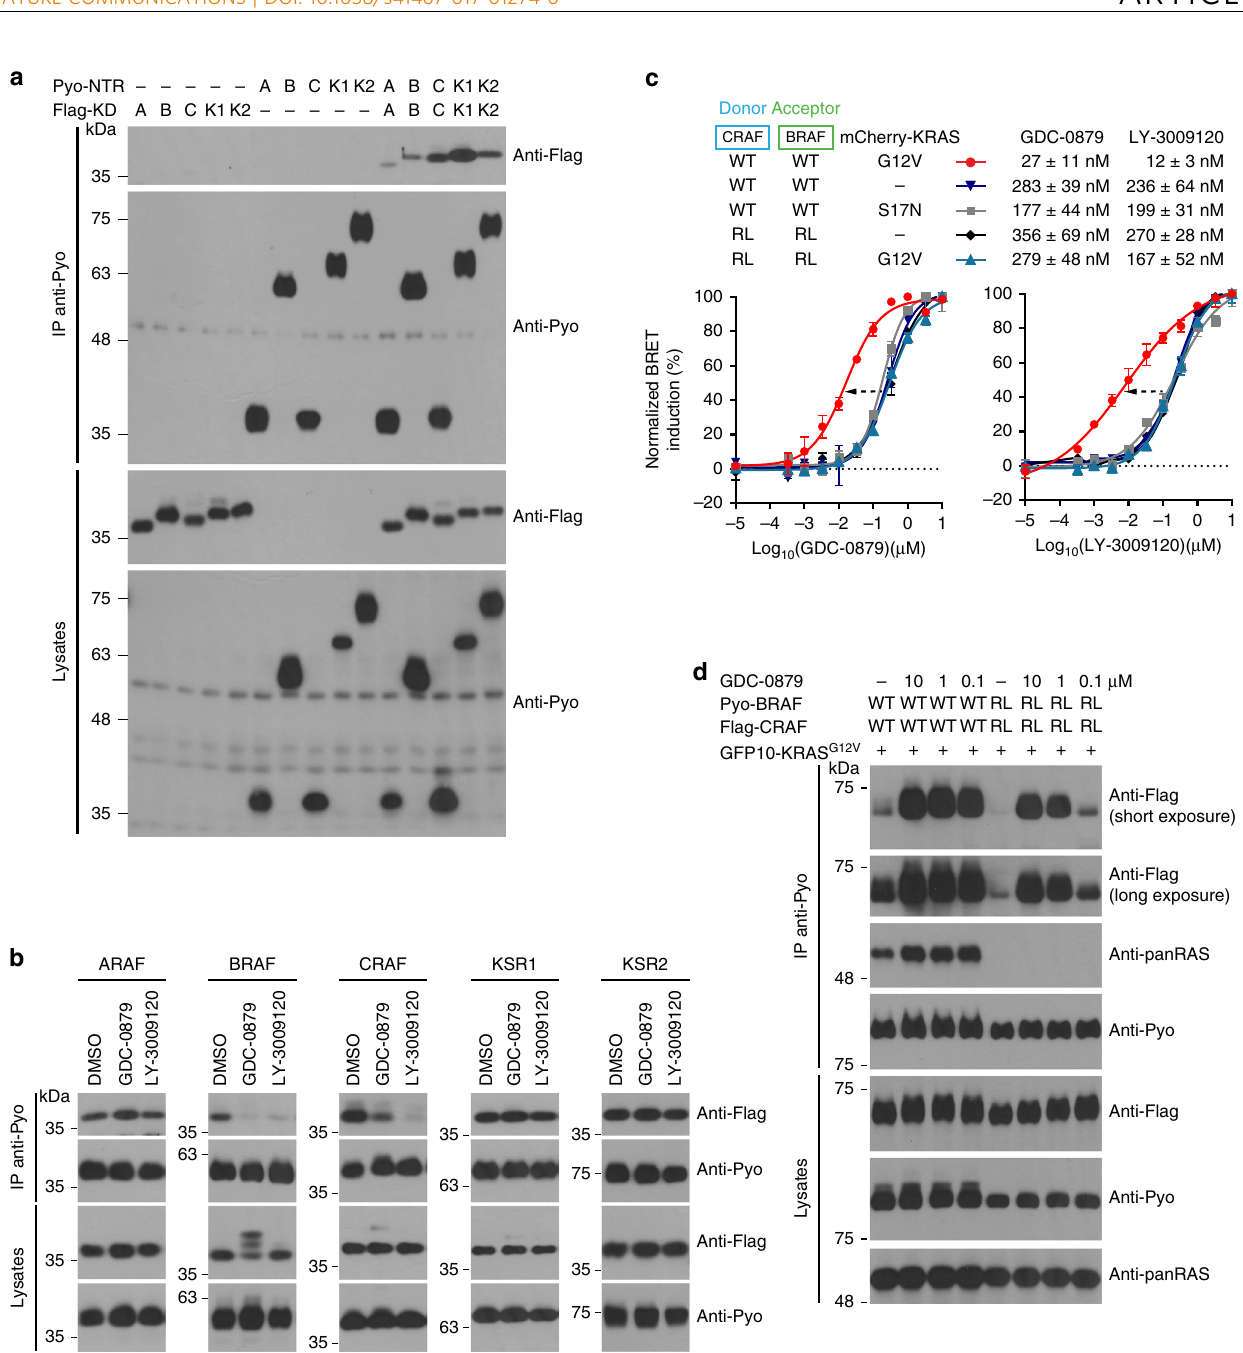
Fig. 4 ON-state RAF inhibitors selectively disrupt BRAF and CRAF intramolecular interactions. a The NTR of each RAF family member interacts speci fi cally with its cognate kinase domain. The strength of the interaction monitored by co-IP varied across isoforms. The NTR of each family member (ARAF (A), BRAF (B), CRAF (C), KSR1 (K1), and KSR2 (K2)) was fused with a N-terminal Pyo tag, while its cognate kinase domain (KD) harbored a N-terminal Flag tag. b The RAF inhibitors GDC-0879 and LY-3009120 selectively disrupt the NTR – KD interaction of BRAF and CRAF, while they had no detectable effect on the other family members (ARAF, KSR1, and KSR2). Cells were treated with 10 µ M of GDC-0879 or LY-3009120. c RAF inhibitors induce BRAF – CRAF dimerization in a RAS-independent manner. GDC-0879 (left) and LY-3009120 (right) induce full-length CRAF-BRAF dimerization in the presence of dominant-negative KRAS S17N (gray) or RBD-mutated BRAF R188L and CRAF R89L (RL, blue curves). Expression of KRAS G12V potentiates (dashed arrows) the effect of both compounds on BRAF – CRAF dimerization (red curves). d Co-IP con fi rms that BRAF R188L and CRAF R89L can form inhibitor-induced, RAS- independent dimers. To facilitate comparison between conditions, the range between minimal and maximal BRET signals was normalized to 100% in c . Error bars in dose-response curves correspond to mean values ± s.d. of technical duplicates of a representative biological triplicate. EC 50 s are the average of at least three independent repeats (Supplementary Data